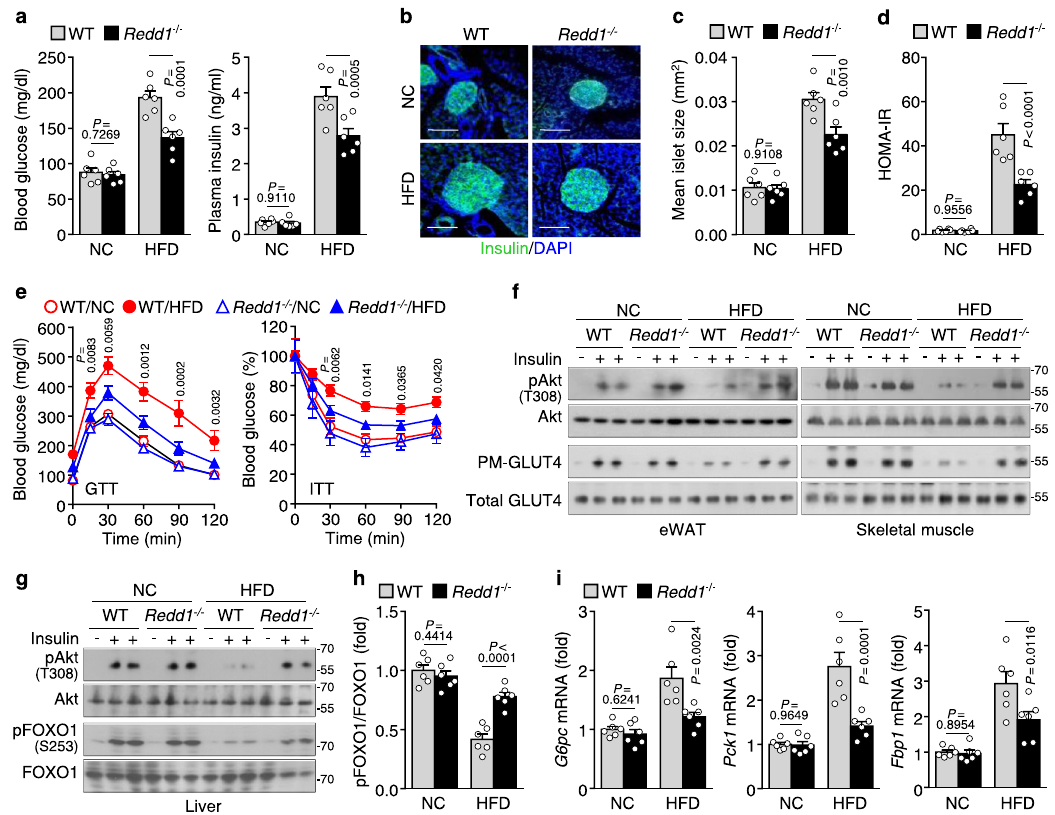
Fig. 2 | Redd1 − / − mice are protected against HFD-induced metabolic dysregu- lation. a Fasting plasma levels of glucose and insulin in NC- or HFD-fed Redd1 − / − miceandtheirWTlittermates( n =6pergroup). b Representativeimagesofinsulin (green)-stained pancreatic islets from NC- or HFD-fed Redd1 − / − mice and WT lit- termates ( n =6 per group). Scale bar, 100 μ m. c Quanti fi cation of average islet size ( n =6 per group). d Calculation of the HOMA-IR scores ( n =6 per group). e Assessment of GTT and ITT in mice fasting for 12 and 6h, respectively, in NC- or HFD-fed Redd1 − / − mice and WT littermates ( n =8 per group). f Representative western blots of Akt phosphorylation and plasma membrane-associated GLUT4